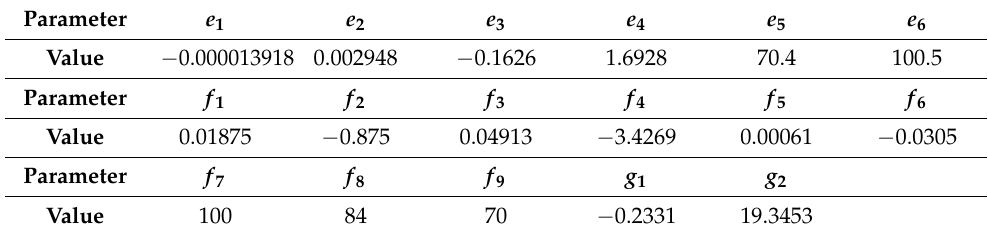
Table 5. Parameters of the models of LQI and PRR.